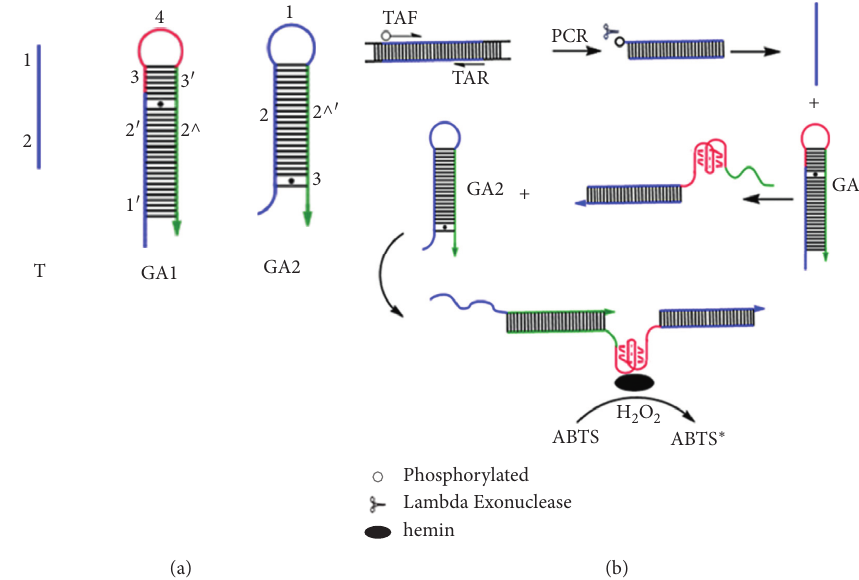
Scheme 1: Schematic diagram of hybridization chain reaction. (a)Target fragment and structure of hairpin probes. The target should be single-stranded DNA. Sequences marked with the same number with or without a single quote (’) are complementary to each other, and the punctuation ( ^ ) indicates that there is only one base difference between them.(b) The process of detecting GmSg-1 by HCR reaction. In the absence of target, the structures of hairpin probes GA1 and GA2 are metastable and G-quadruplex is enclosed in the loop. Once the target is present, probes GA1 and GA2 are opened successively and hybridization chain reaction was generated, lots of G-quadruplex are released and combined with hemin to catalyze the oxidation of ABTS by H 2 O 2 to green ABTS + .